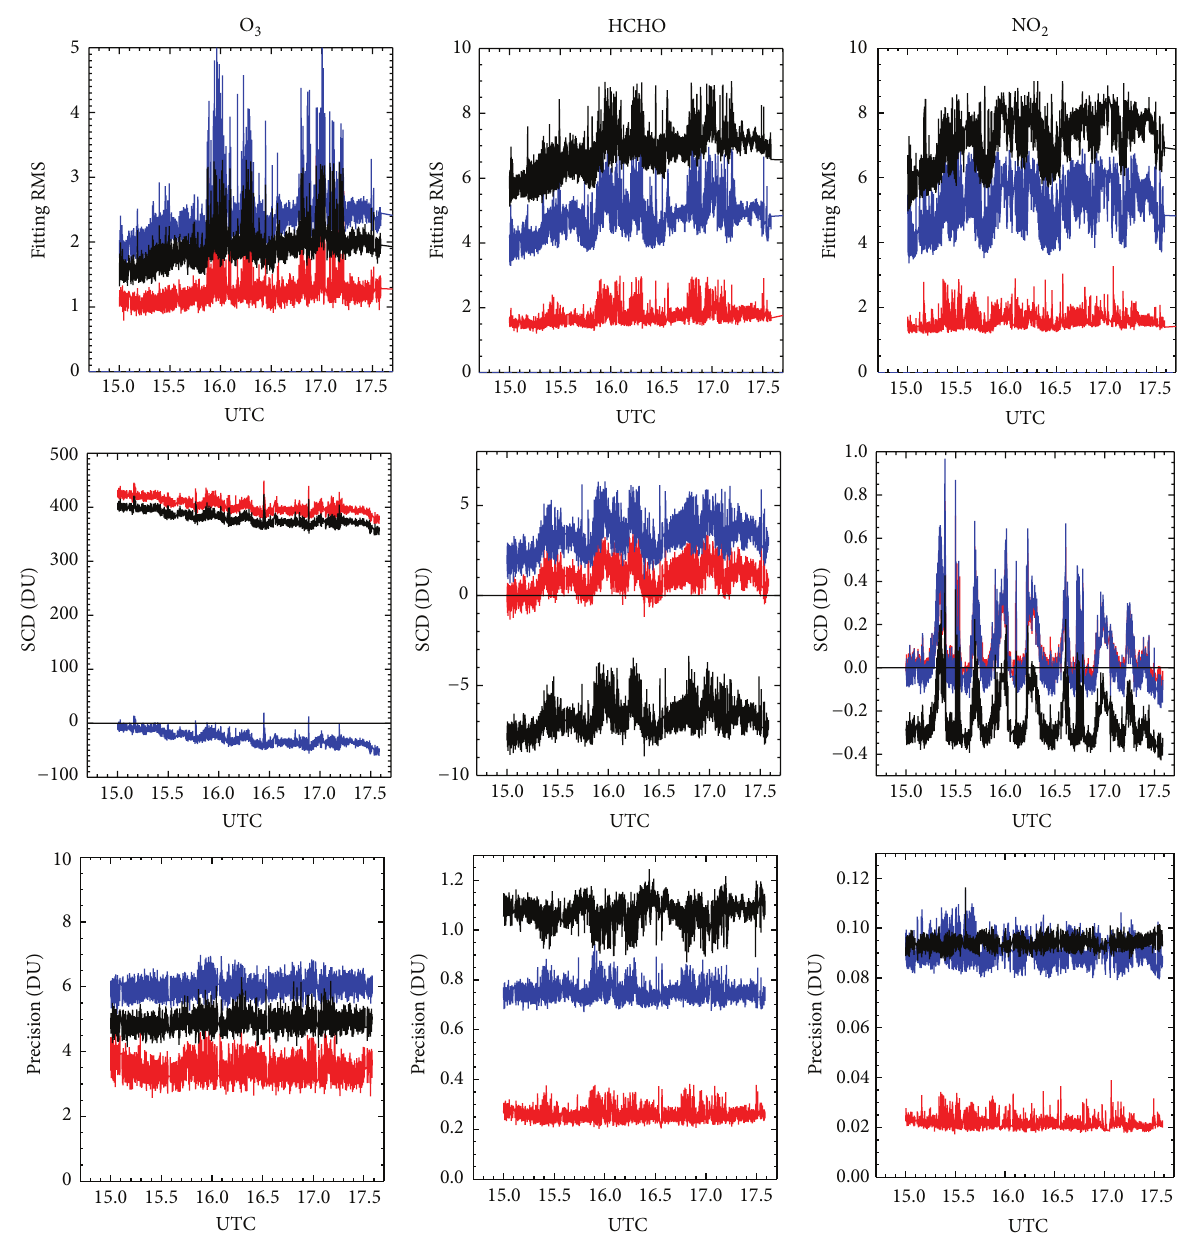
Figure 3: Comparison of O 3 (left), CH 2 O (middle column), and NO 2 (right) fitting in (top) relative RMS, (middle row) SCDs, and (bottom) precision of SCDs for ACAM measurements from July 21, 2011, using three different reference spectra: average zenith reference (blue), high- resolution solar irradiance convolved with instrument slit functions (black), and derived TOA solar irradiance from average nadir radiance spectrum